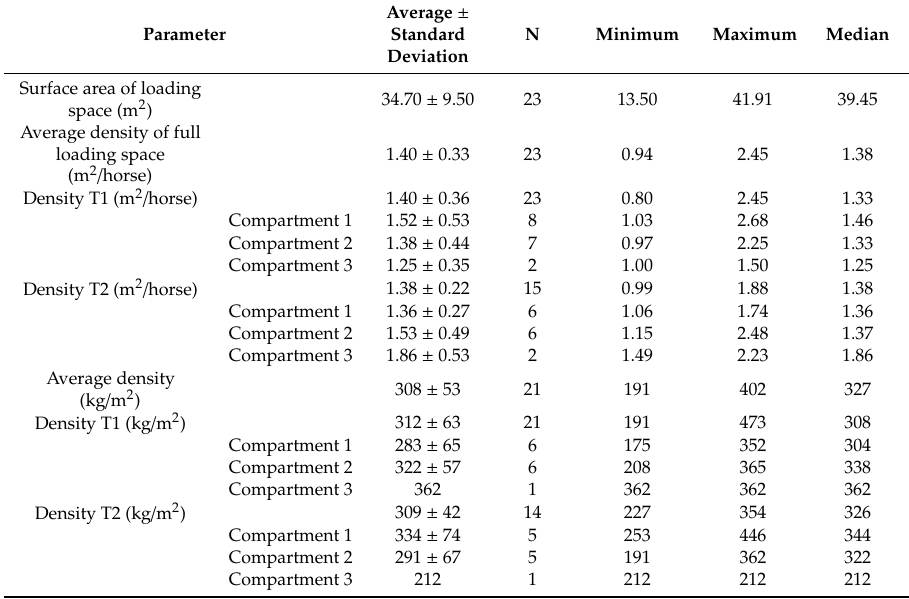
Table 5. Average available space per horse (m 2 / horse) and average density (kg / m 2 ). T1 = front loading space; T2 = rear loading